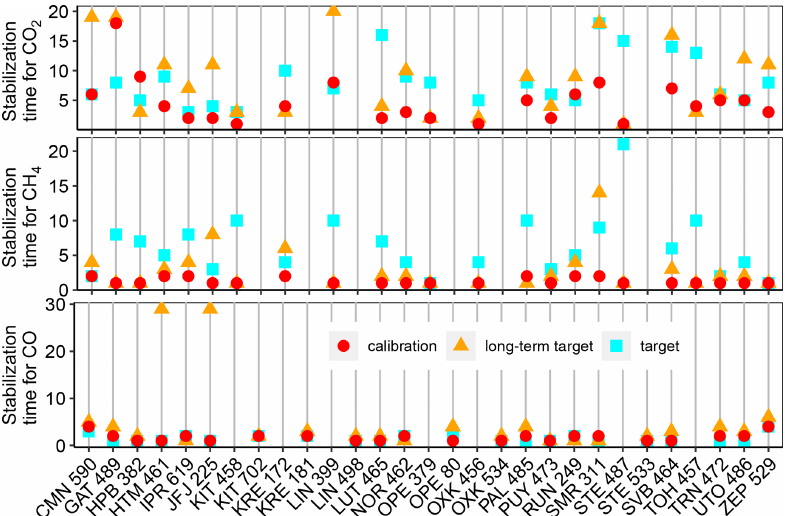
Figure 15. Stabilization time (minutes) for CO 2 , CH 4 and CO at the 23 stations at the time of the labeling. Red shows the calibration, green the long-term target and blue the short-term target. On the x axis, the trigram of the station and the ICOS ID of the analyzer are shown. Data from CRDS and OA-ICOS analyzers are